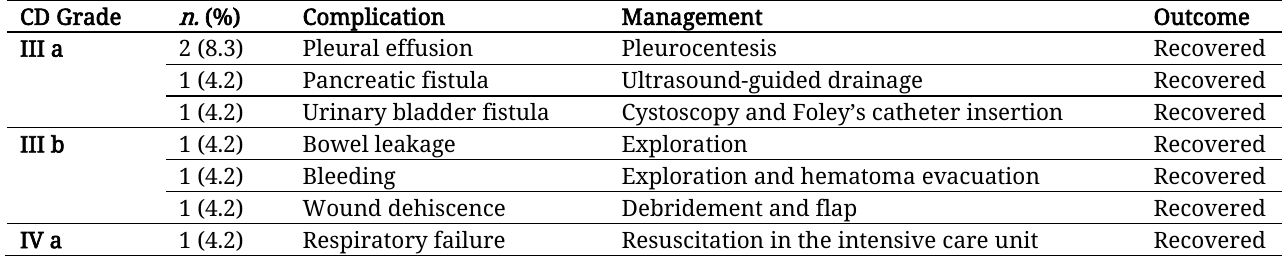
Table 4: Management and outcome of grade III and IV Clavein Dindo (CD) complications